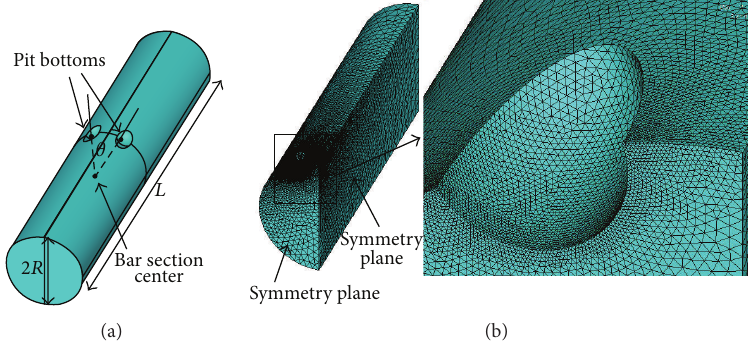
Figure 2: Illustration of two transverse pits’ problem: (a) geometric configuration of steel bar and corrosion pit; (b) finite element model.